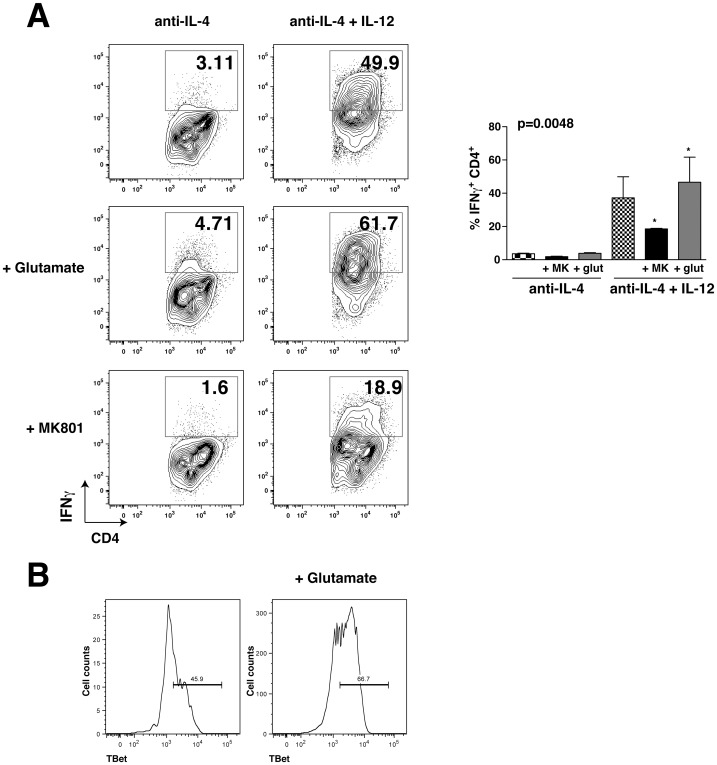
Th1 cell differentiation is promoted by glutamate.(A) CD4+ T cells were cultivated on irradiated splenocytes in the presence of 10 µg/mL anti-IL-4 alone or with 10 ng/mL IL-12 for 4 days, with or without 100 µM MK801 or 100 µM glutamate, each of which was reloaded after 2 days of polarization. Cells were washed and restimulated with PMA/ionomycin/BFA for 4 h and analyzed by flow cytometry. Flow cytometry analyses were quantified and expressed as mean ± s.e.m. (n = 3, one-way ANOVA test, *p<0.05). (B) CD4+ T cells were cultivated on irradiated splenocytes in the presence 10 µg/mL anti-IL-4 for 4 days with or without 100 µM glutamate, and cells were washed and restimulated with PMA/ionomycin/BFA for 4 h and analyzed by flow cytometry. The histogram represents TBet expressing cells.